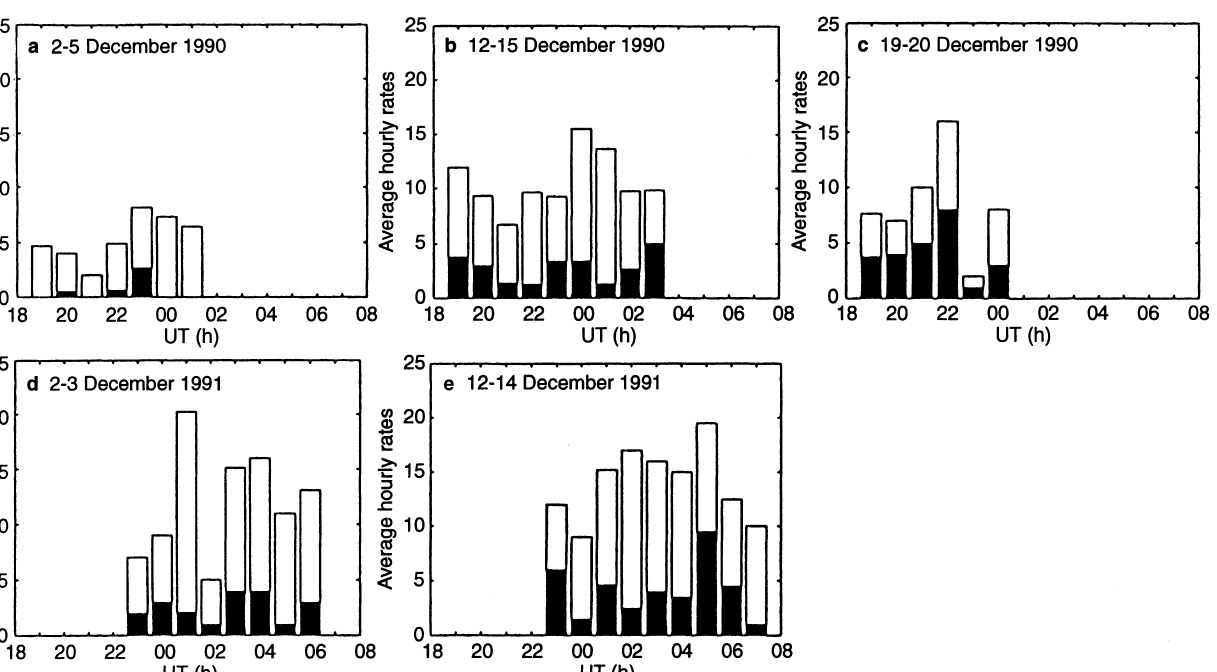
Fig. 4. As Fig. 3, but showing meteor trail echoes from an ionized trail left behind a meteor from the EISCAT UHF radar. This echo can be detected in